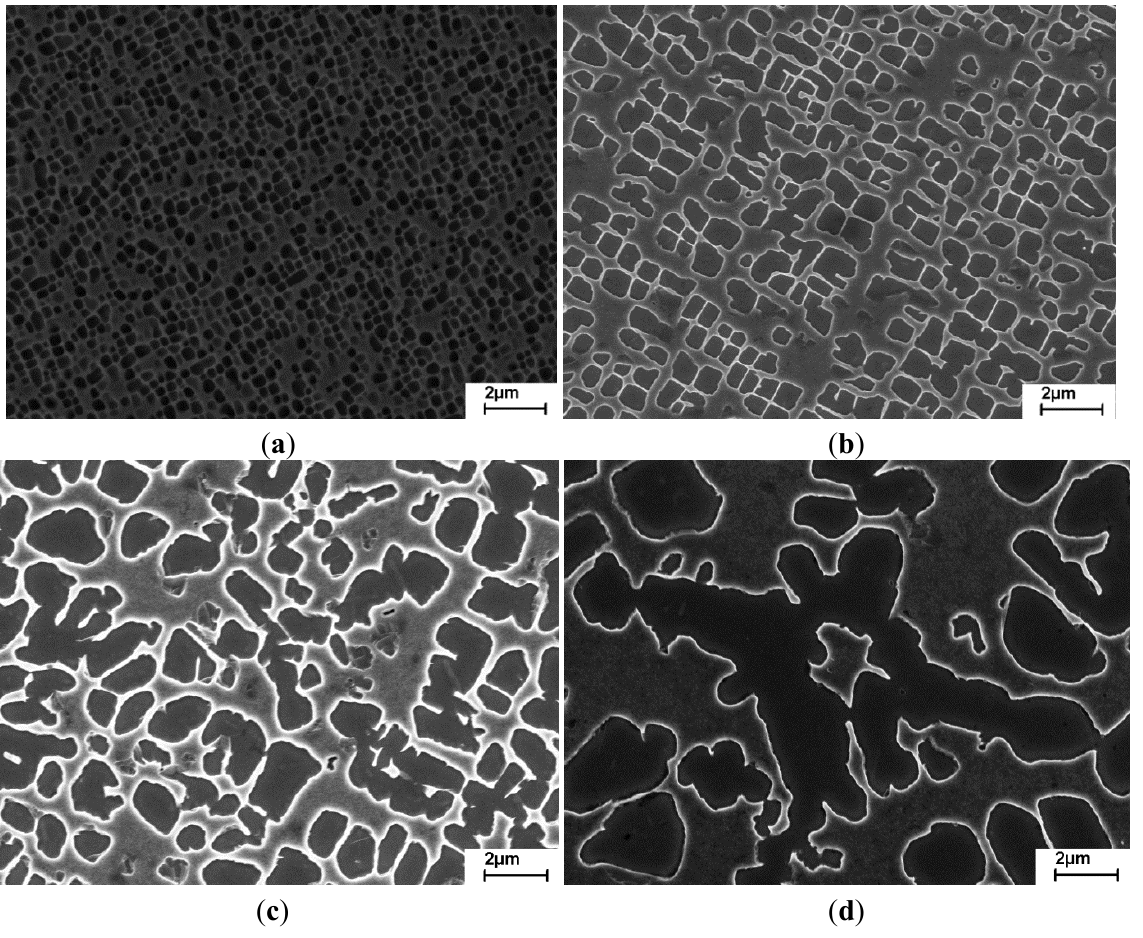
Figure 1. Microstructure in the solution and precipitation heat treated state, as a function of the cooling rate from solution heat treatment ( a ) air cooling ( b ) 4 K/min ( c ) 1 K/min ( d ) 0.2 K/min